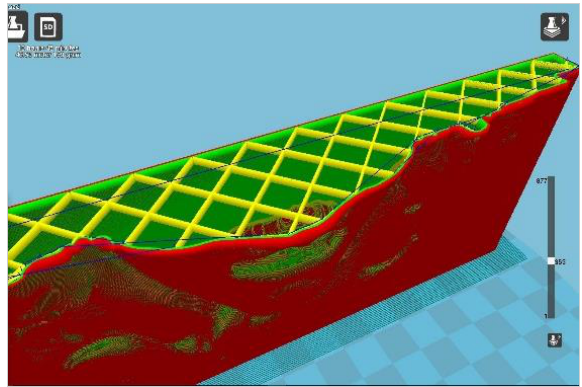
Figure 11. The main screen of Cura; the Medusa mask, vertical position, layers view mode. Detail of its fill